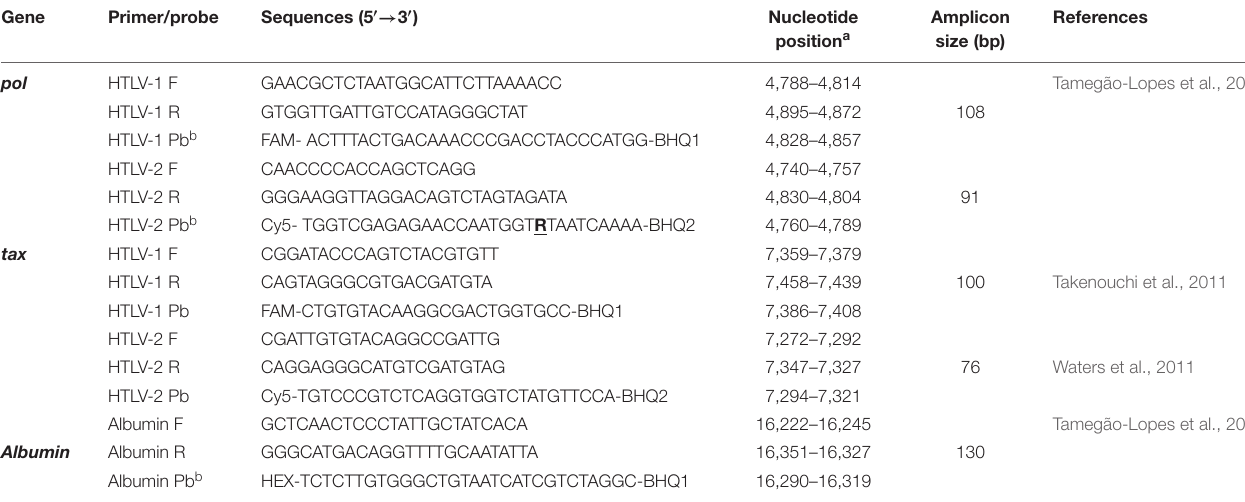
TABLE 1 | Primers and probes employed in two multiplex qPCR_HTLV assays ( pol and tax ) for detecting HTLV-1 and HTLV-2. Gene Primer/probe Sequences (5 (cid:48) → 3 (cid:48)